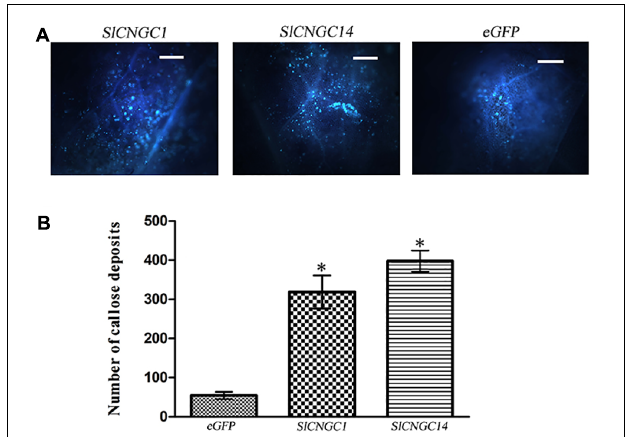
FIGURE 2 | Silencing of SlCNGC1 and SlCNGC14 increased Xoc -induced callose deposition. Leaves inoculated with Xoc at 4 hpi were stained with aniline blue and visualized in fluorescence microscope. A typical staining result (A) and its quantification result (B) were shown. Significant differences between treatments and the control are indicated by an asterisk ( p < 0.05).